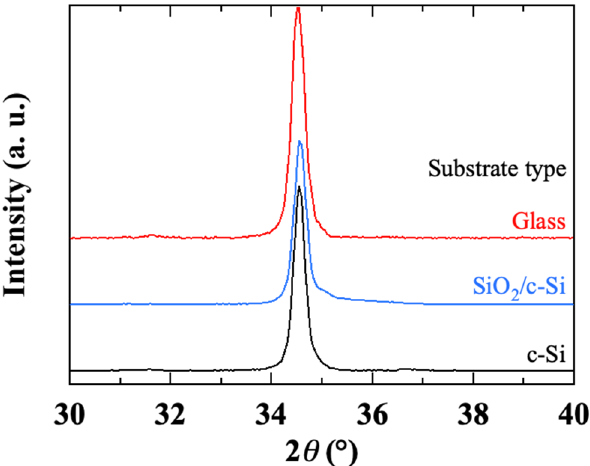
Figure 13. X-ray diffractograms of sol-gel spin-coated ZnO thin films deposited on different substrates.